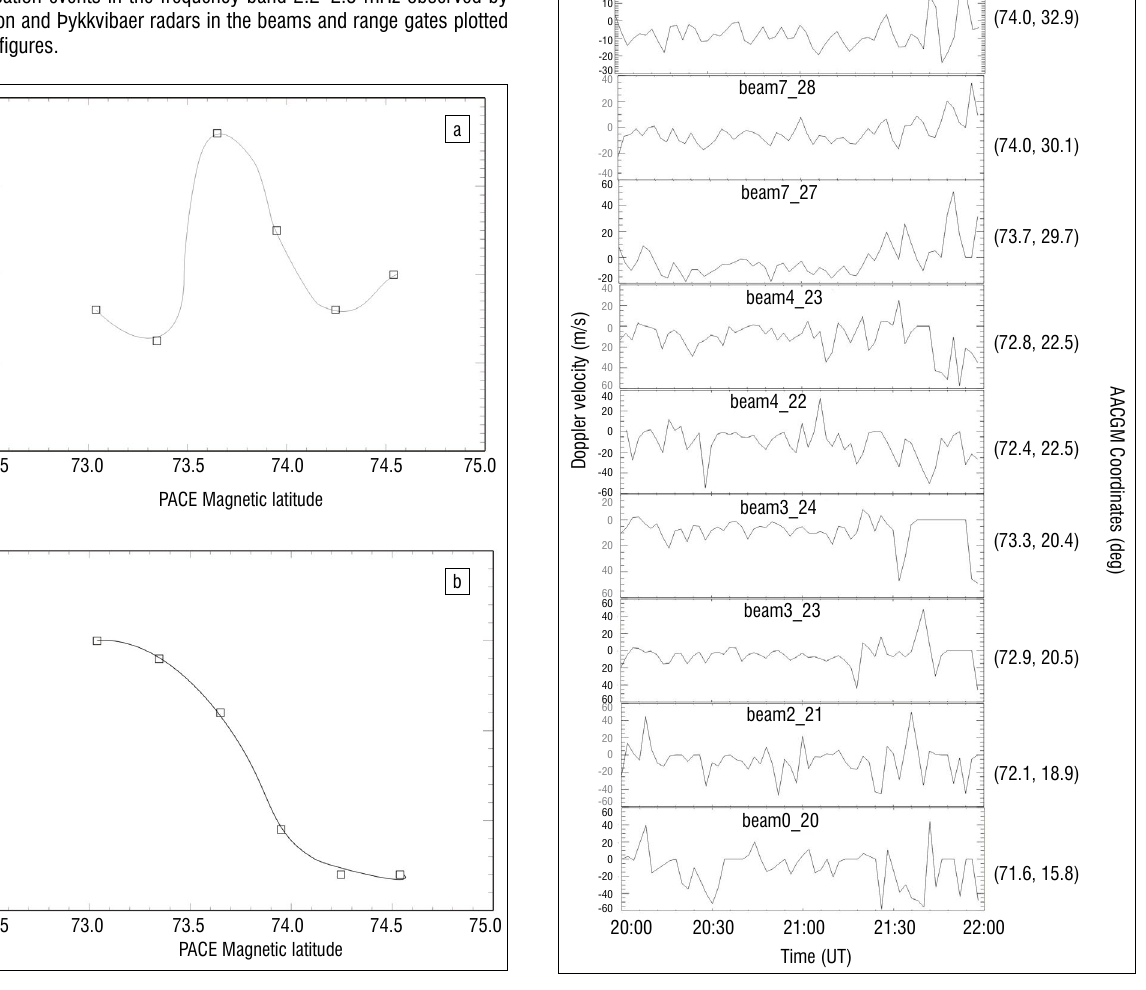
Figure 2: Latitude profile of (a) amplitude and (b) phase along beam 10 (the beam most aligned with the magnetic meridian) of Goose Bay.